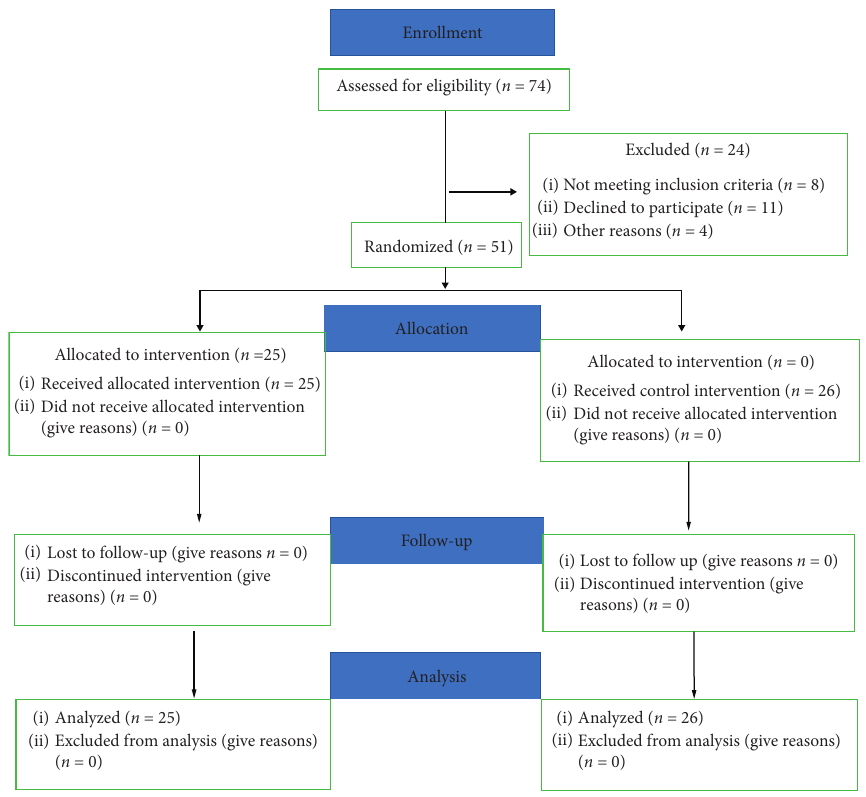
Figure 1: CONSORT diagram showing flow of